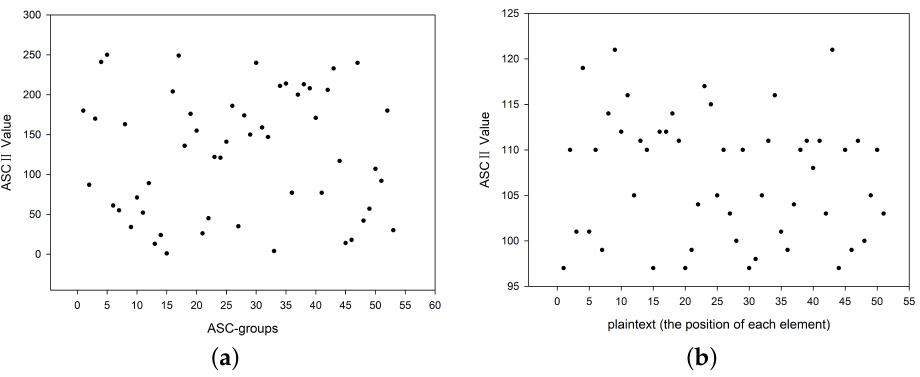
Figure 7. The ASCII value distribution of ( a ) the plaintext and ( b ) the